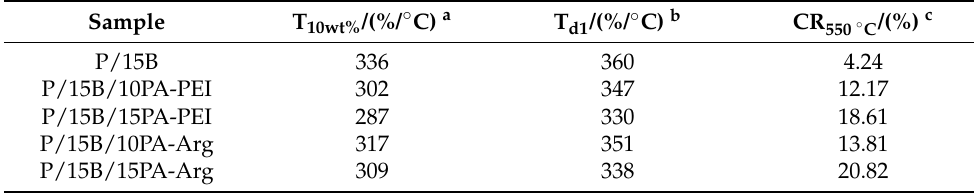
Table 3. TGA and DTG data of PLA/PBS-based bicomposites under N 2 atmosphere.